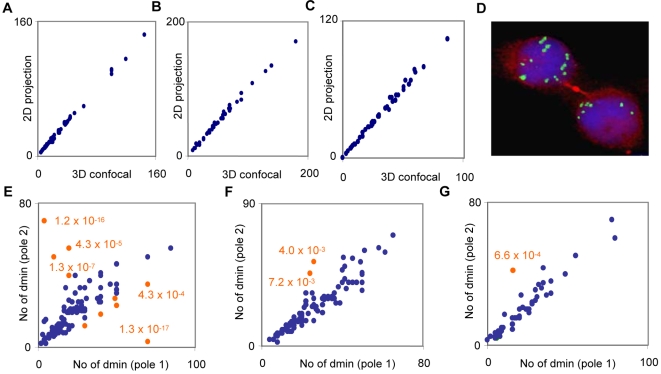
Statistics of DM segregation.A–C. DM copy-numbers in interphase nuclei obtained by scoring 1 µm confocal optical sections (three-dimensional, 3D) plotted against the copy-number obtained by scoring a projected (two-dimensional, 2D) image in LA-N-5 (A), CHP-212 (B) and MC-IX (C). D. Segregation of 7 and 10 DMs, respectively, to each daughter cell at telophase, shown by IF for beta tubulin (red) and FISH for MYCN (green). E–G. DM copy-numbers in ana/telophase poles typically follow a binomial distribution (blue data points) in LA-N-5 (E), CHP-212 (F), and MC-IX (G); ana-telophase cells significantly (p<0.01) deviating from the binomial distribution are denoted by orange data points.